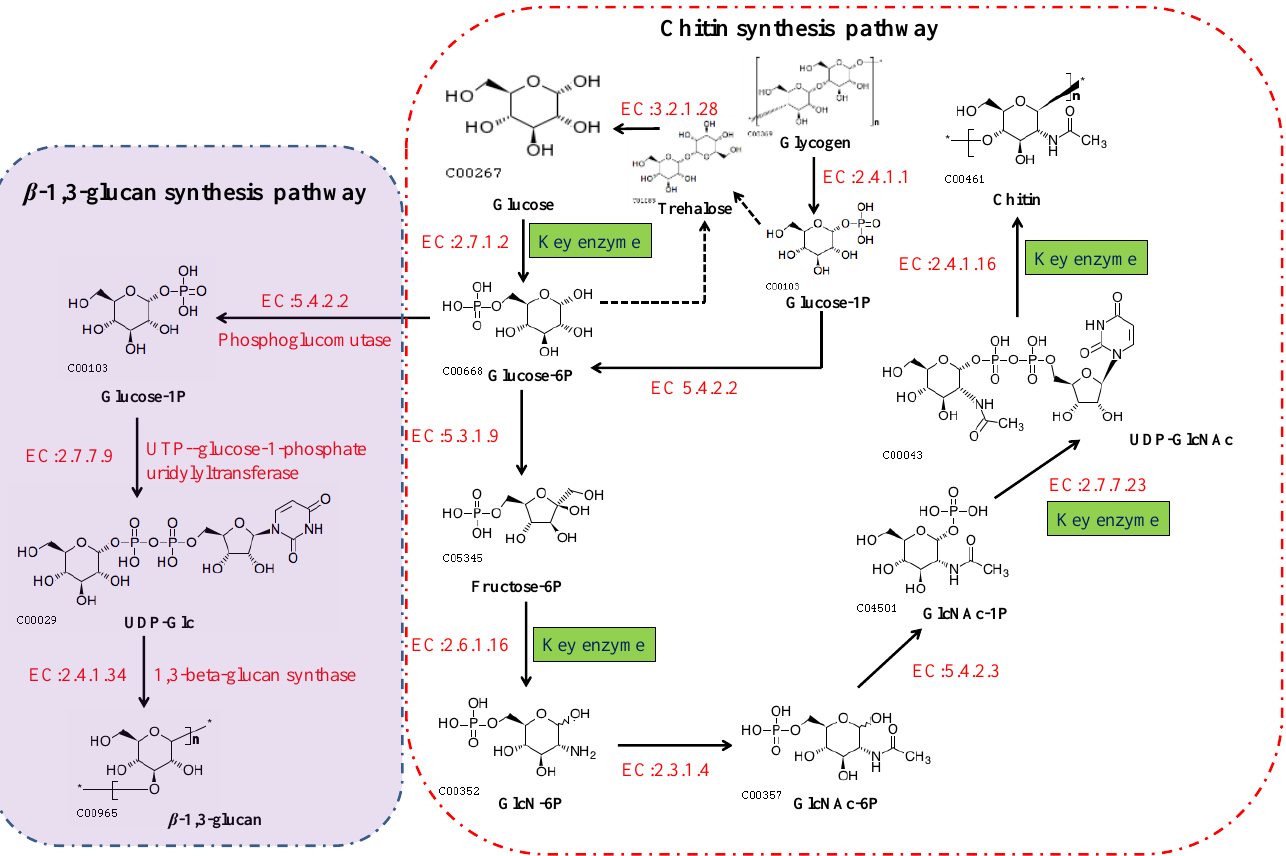
Figure 3. The biosynthetic pathways of chitin and β -(1,3) glucan in fungi. These pathways can also be viewed at the Kyoto Encyclopedia of Genes and Genomes website ( https://www.kegg.jp/pathway/map00520, accessed on 11 September 2021.).